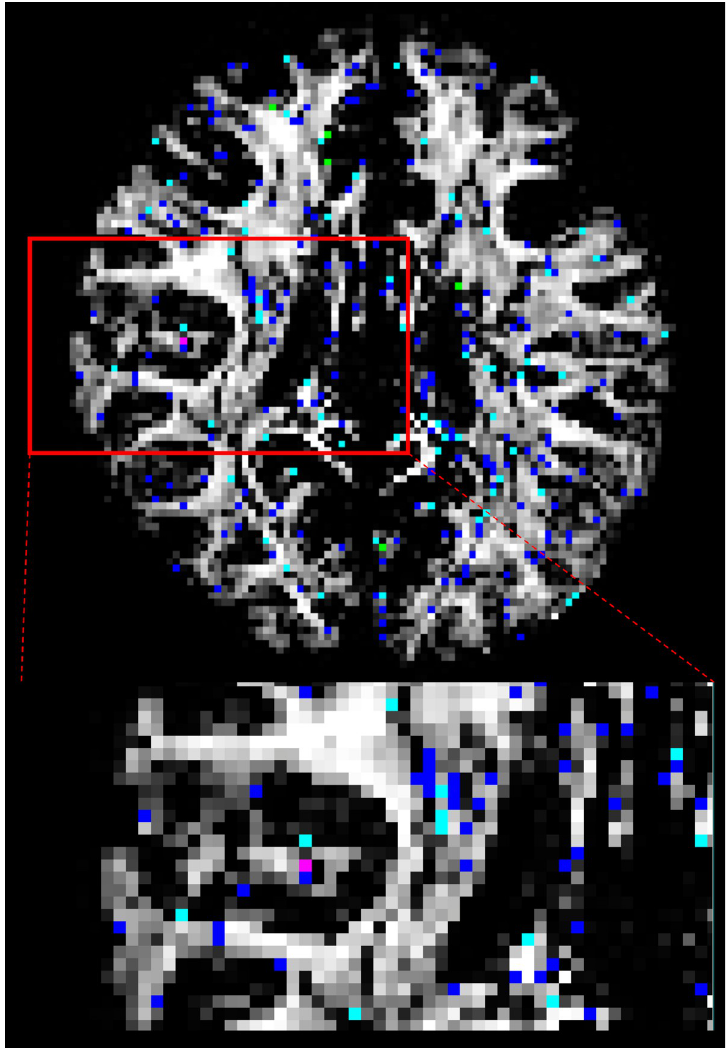
Fig 4. Significantly different f 2 map where f 2 > 0.05. Significantly different f 2 with mean f 2 in CPU or GPU > 0.05. S- score ranges are in: 0.1–0.2 = blue, 0.2–0.3 = light-blue, 0.3–0.4 = green, > 0.4 = magenta (enlarged view from area in